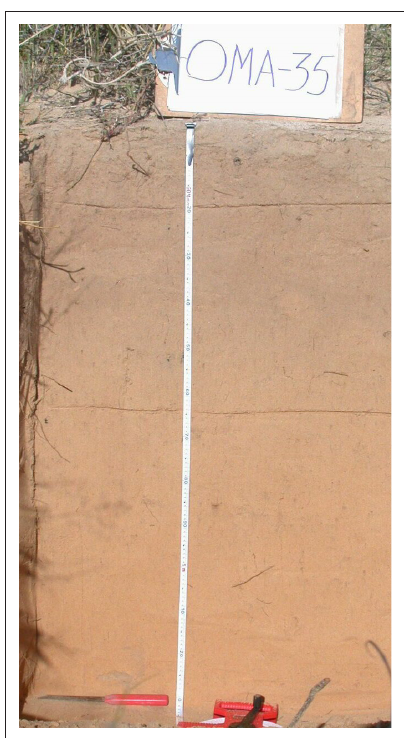
FIGURE A1.6: Typical profile of a haplic Arenosol showing the ochric A-horizon overlying a dark brown Bw1-horizon, followed by a leached Bw2-horizon. FIGURE A1.2: Typical calcaric